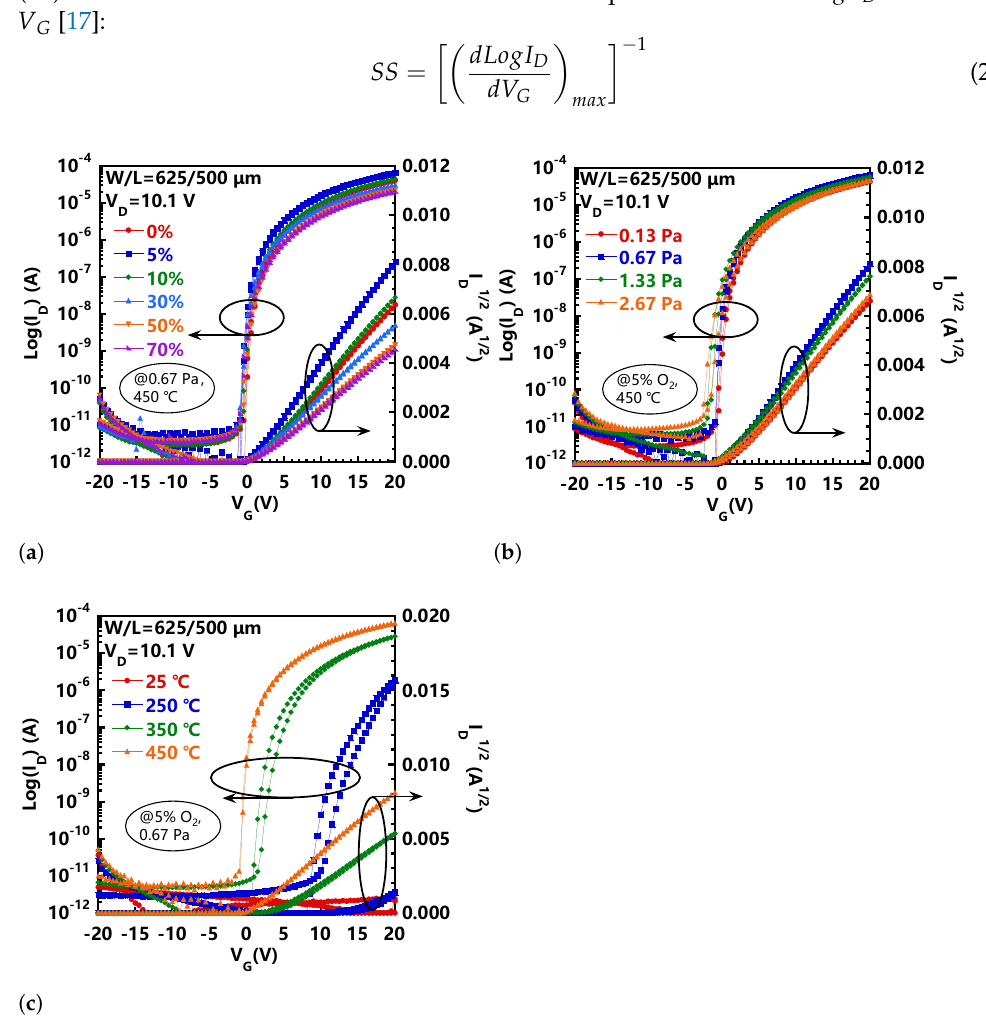
Figure 4. Transfer characteristics of TFTs using a-IGZO films deposited at ( a ) different O 2 /(Ar+O 2 ) ratio, (for 0.67 Pa, 450 °C), ( b ) sputtering pressure (for 5% O 2 , 450 °C), and ( c ) annealing temperature (for 5% O 2 , 0.67 Pa). Table 1. Variation of the performance for both a-IGZO